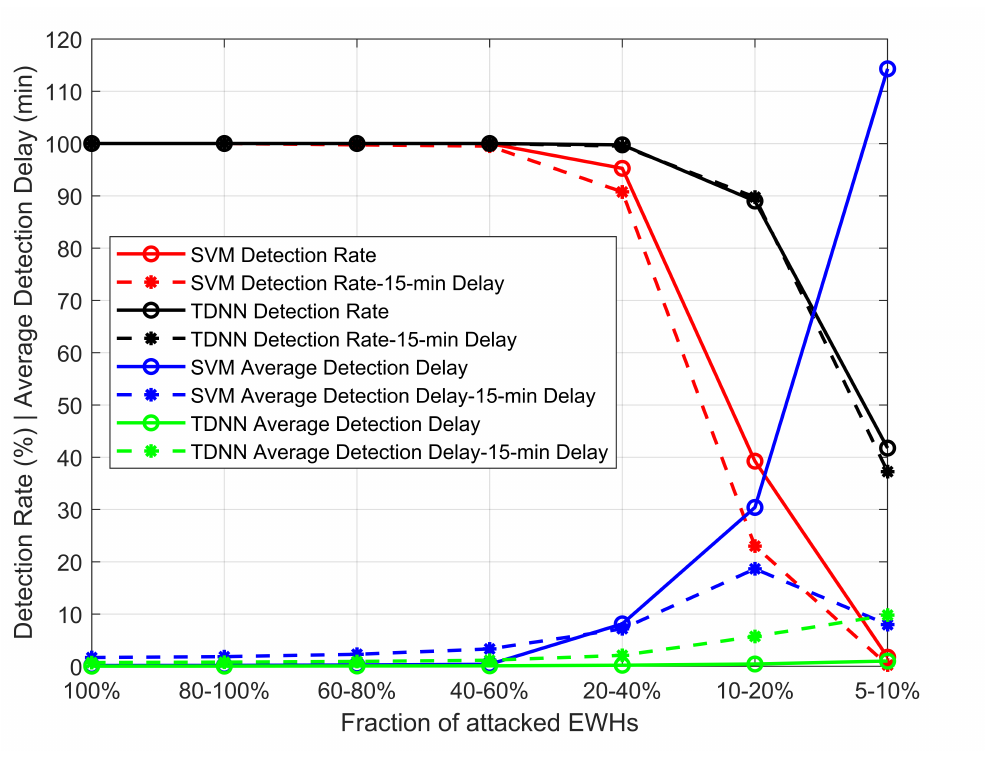
Figure 4. Impact of attacking subsets of EWHs on the detection rate and average detection delay of the proposed LAA detector with and without